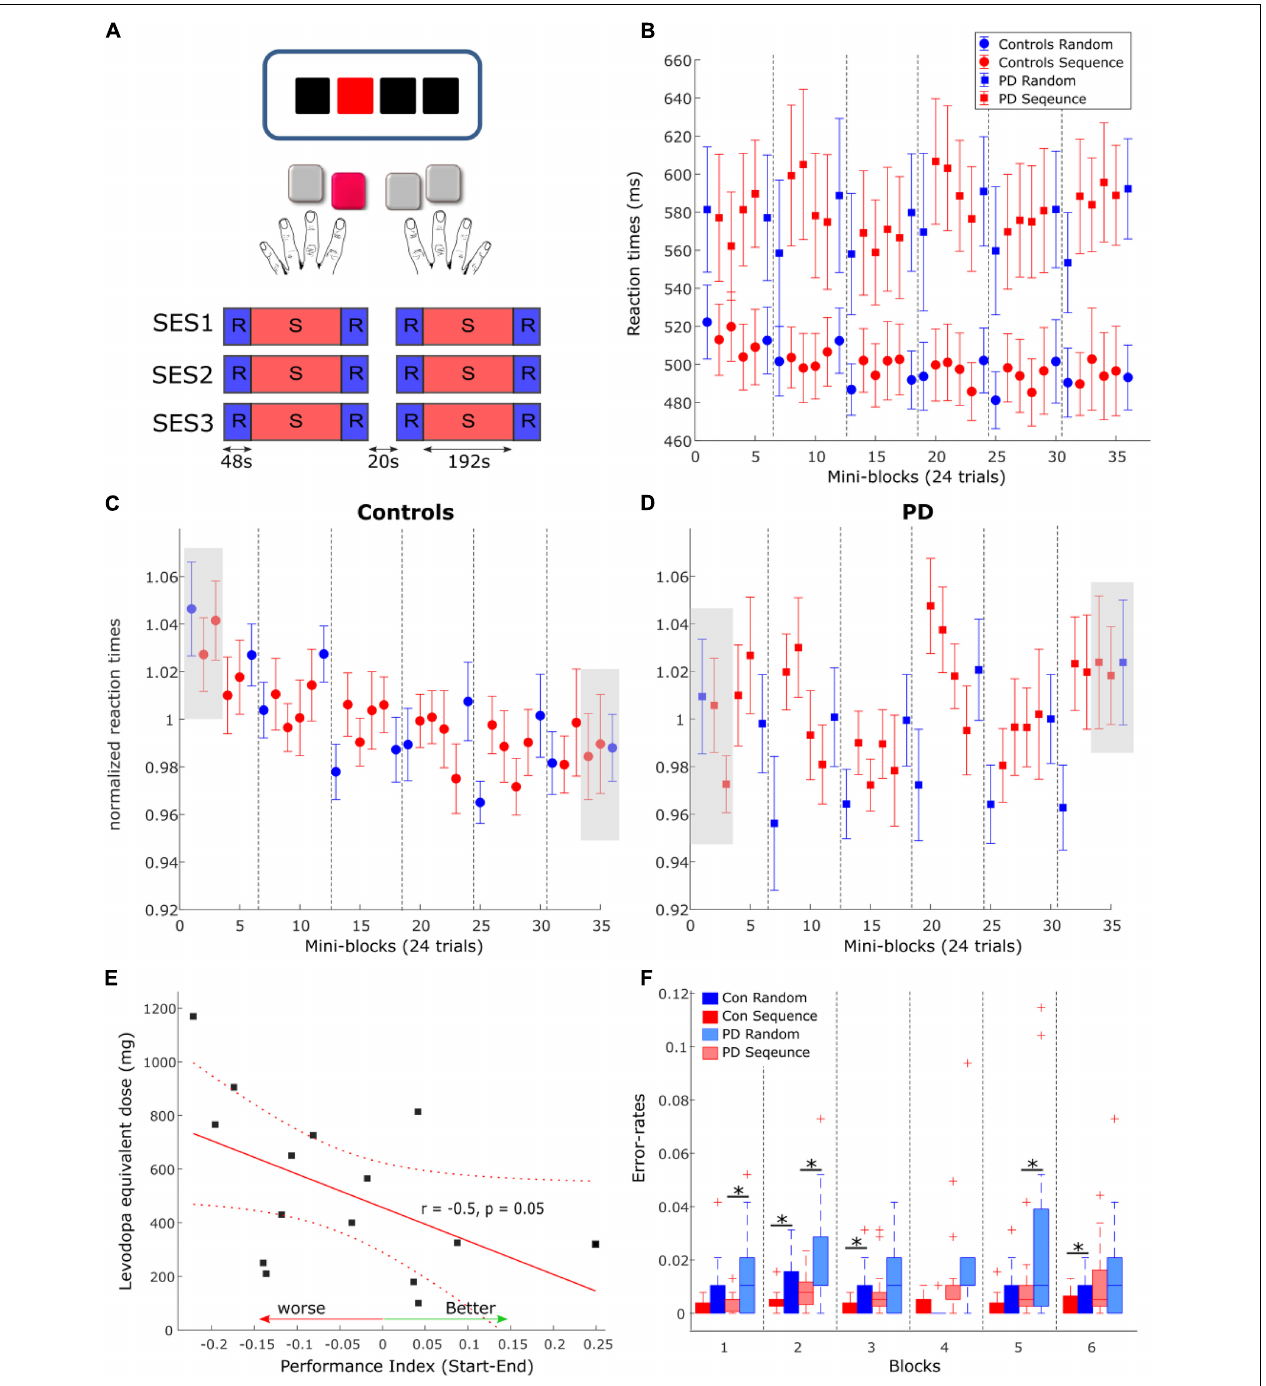
FIGURE 1 | (A) Task and experimental design. In each trial, subjects viewed three black squares and one red square which served as the target. Subjects were instructed to press the button corresponding to the location of the red square. The task consisted of three MRI sessions (SES1-SES3) including two blocks each, amounting to a total of six blocks. 20 s breaks were introduced between sessions and blocks. (B) Reactions times in PD (squares) and controls (circles) in each condition and each mini-block of 24 trials. Error-bars are standard error of the mean across subjects in each group. Dashed gray lines depicts the breaks between the blocks. (C,D) Normalized reaction times in healthy controls (C) and PD (D) . Gray boxes show the blocks used for comparison of performance between groups. (E) Correlation between the performance index, calculated as the differences between the first three blocks of normalized RTs and the last three blocks, and the levodopa equivalent dose. (F) Error rates in each condition and each block for PD (light colors) and healthy controls. Asterisks mark significant differences within the group.